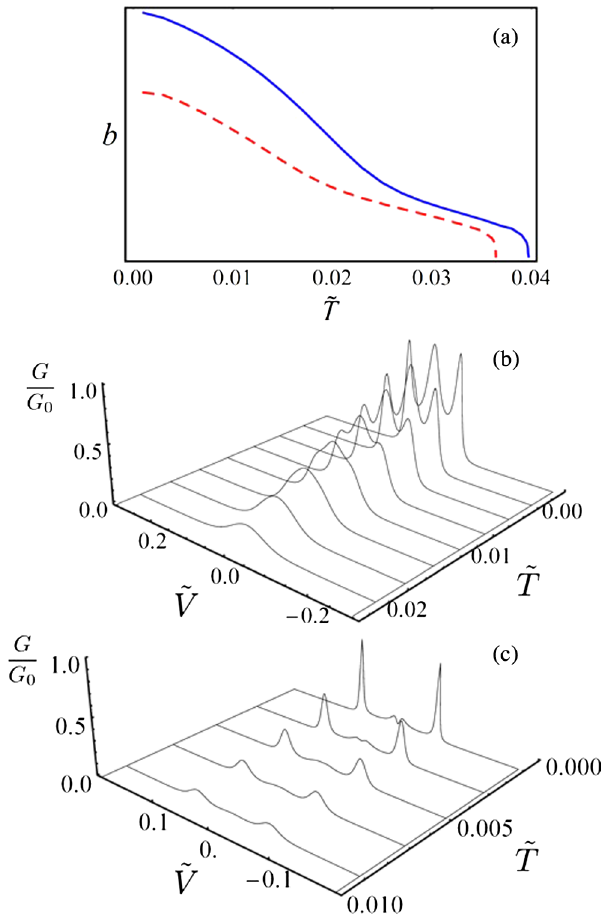
FIG. 7. Dependence of the tunneling conductance G ð V; T Þ on temperature and voltage bias. (a) The solution of the variational parameter b as a function of temperature T . Here, all the energy scales are rescaled by Γ ; the parameters are ε ¼ − 3 . 5 , λ ¼ 0 . 5 , and δ ¼ 0 (solid line) and δ ¼ 0 . 1 (dashed line). The other variational parameter η is weakly dependent on temperature. (b), (c) The plots of the tunneling conductance G ð V; T Þ as a function of temperature T and voltage bias V for δ ¼ 0 and δ ¼ 0 . 1 ,